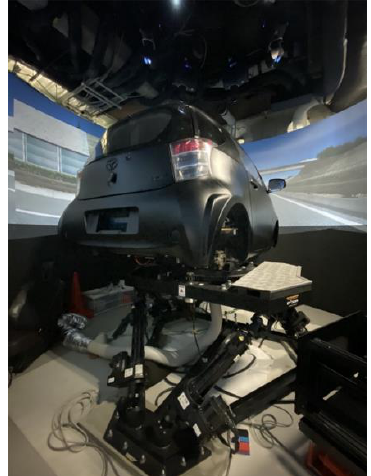
Figure 1. Driving simulator.